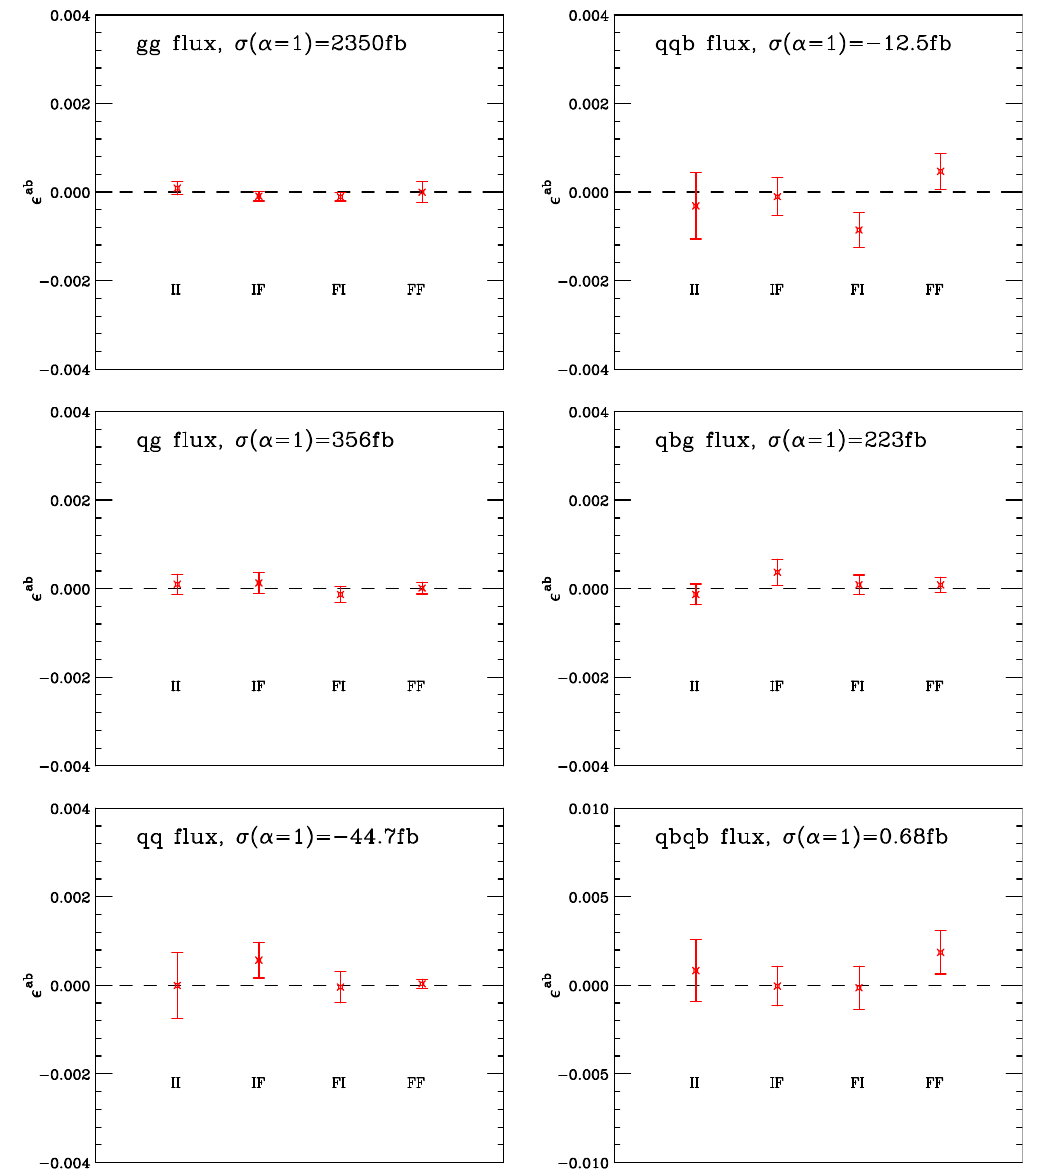
Figure 1 . The dependence of the H +2 j cross-section on the (cid:11) parameters, for each of the di(cid:11)erent partonic (cid:13)uxes. The points represent the deviation from the default ( (cid:11) II = (cid:11) IF = (cid:11) FI = (cid:11) FF = 1) when the labelled parameter is set to 10 (cid:0) 2 , according to eq. (2.3). The cross-sections in each channel, obtained using the default parameters, are indicated in the plots.